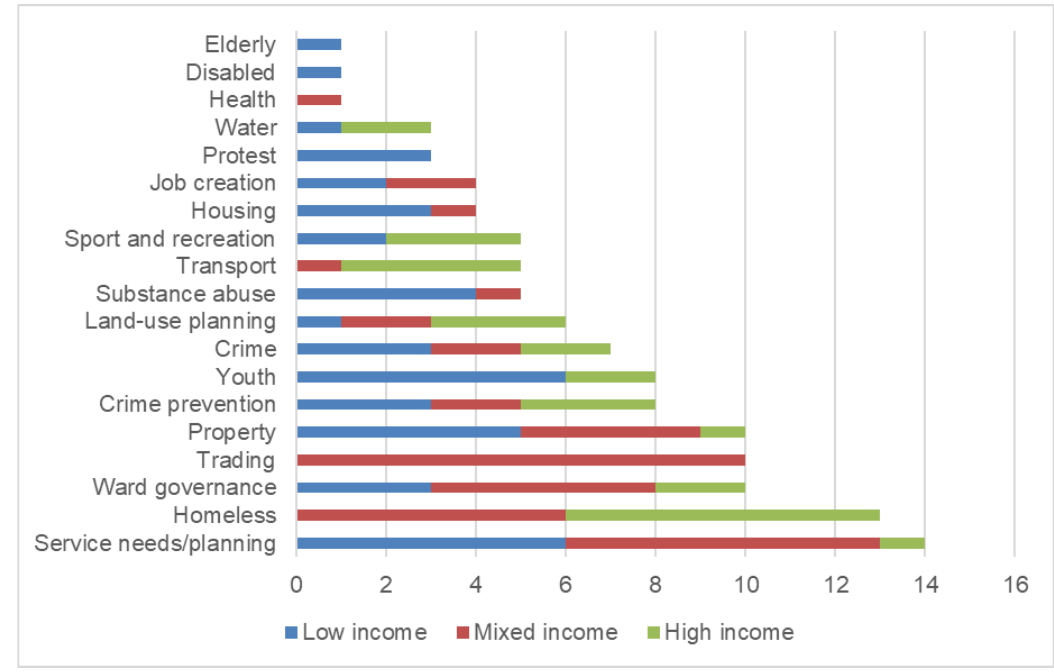
Figure 3: Frequency of issue areas by ward income in community media coverage